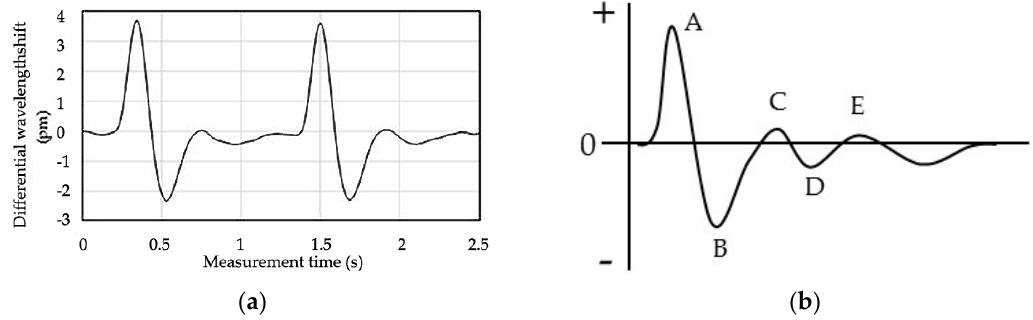
Figure 3. Measured pulse wave signal and basic acceleration plethysmogram. ( a ) Pulse wave signal measured with the FBG sensor; ( b ) Acceleration plethysmogram.